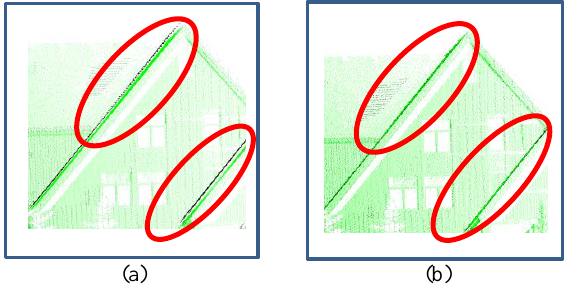
Figure 10. Registration using the matched linear features (a) and registration using the ICPP